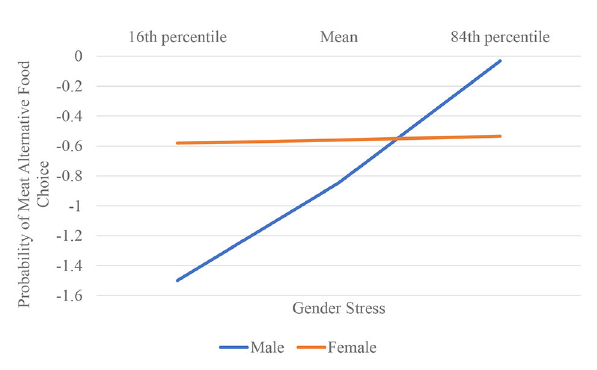
FIGURE1 Gender stress by gender on probability of selecting meat alternative within a masculine product (study 2).